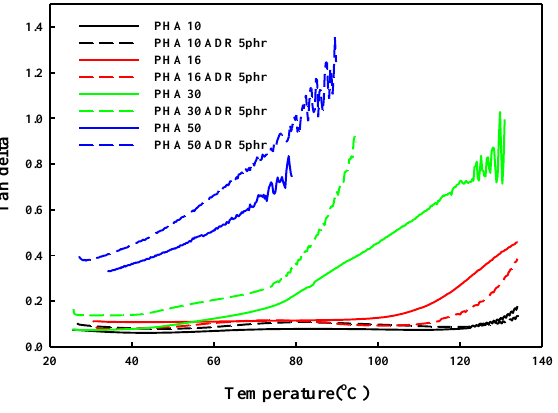
Figure 4. DMA thermograms of various P(3HB- co -4HB) with and without ADR.